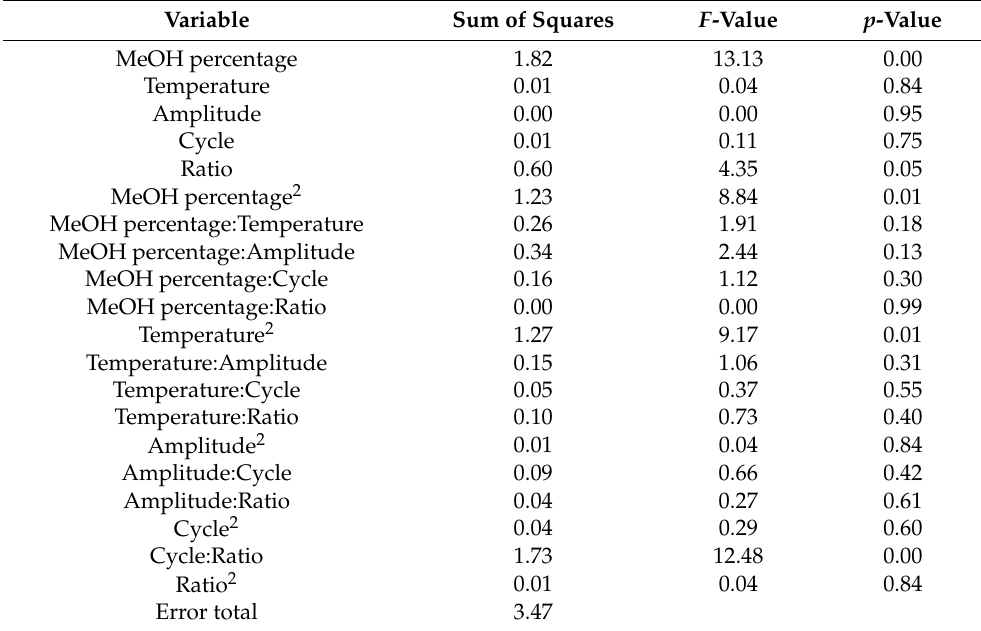
Table 1. Results from the BBD–RSM for Total Phenolic